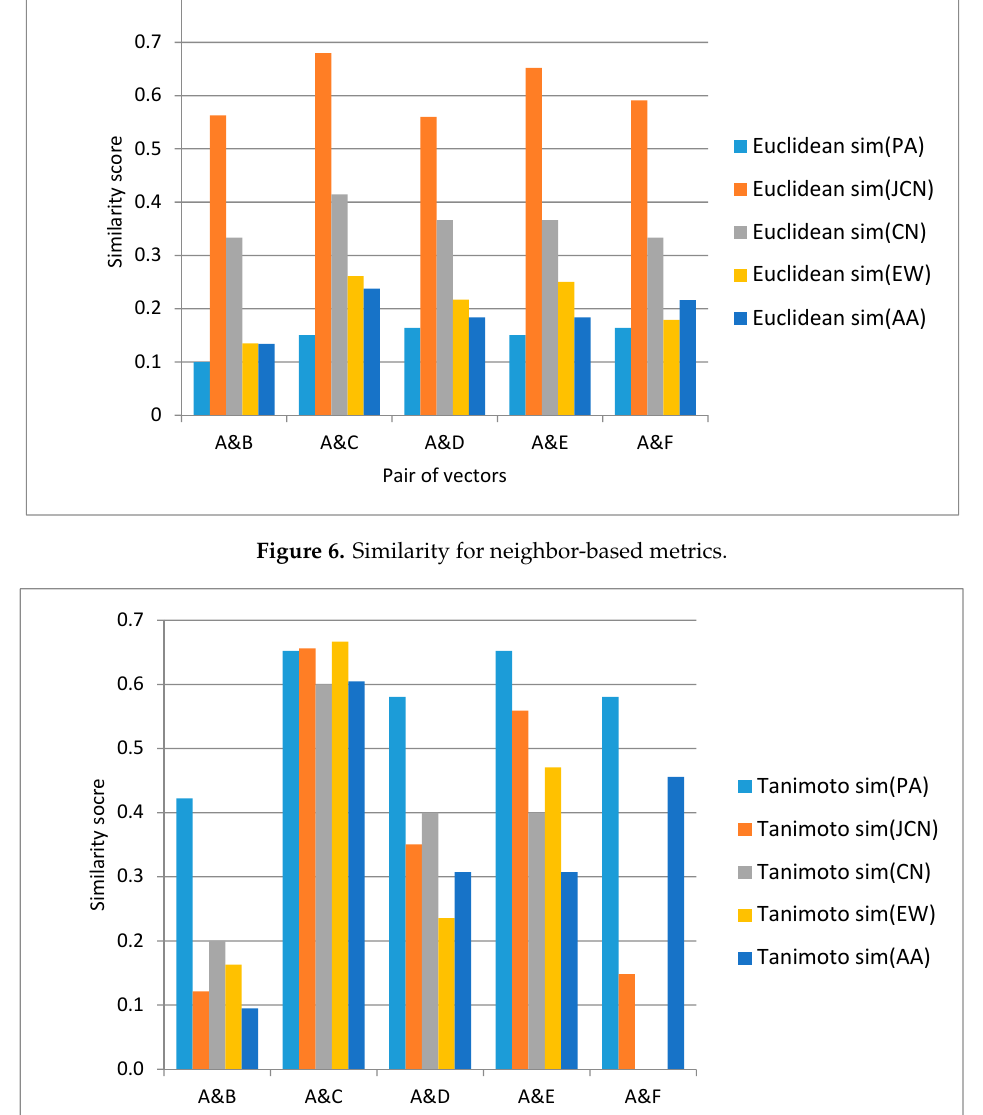
Figure 7. Coefficient similarity for neighbor based metrics.